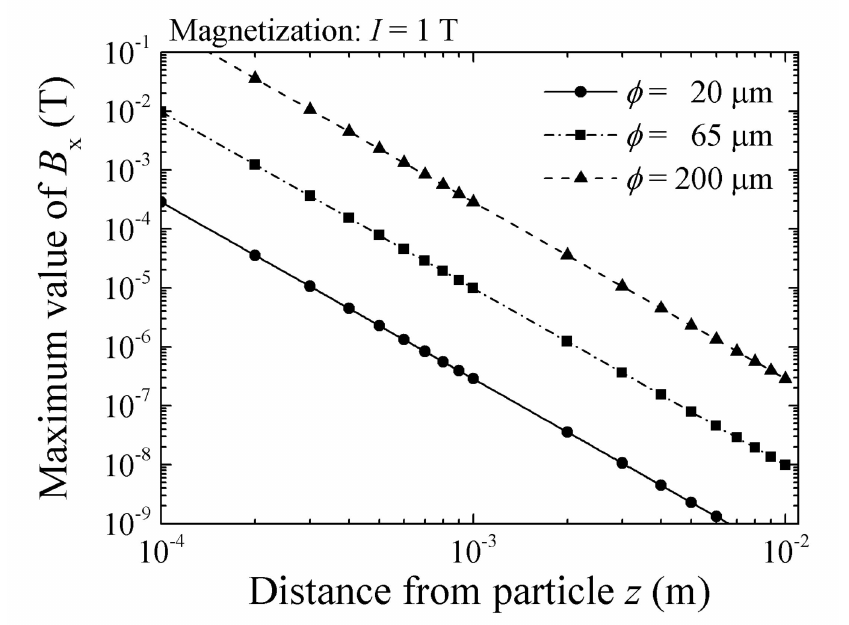
Figure 21. Variations in magnetic flux density at sensor element position as a function of feeding height z [19]. (The magnetization of particle: 1 T. The diameter of the sphere particle φ : parameter. The configuration of measurement system is the same as this